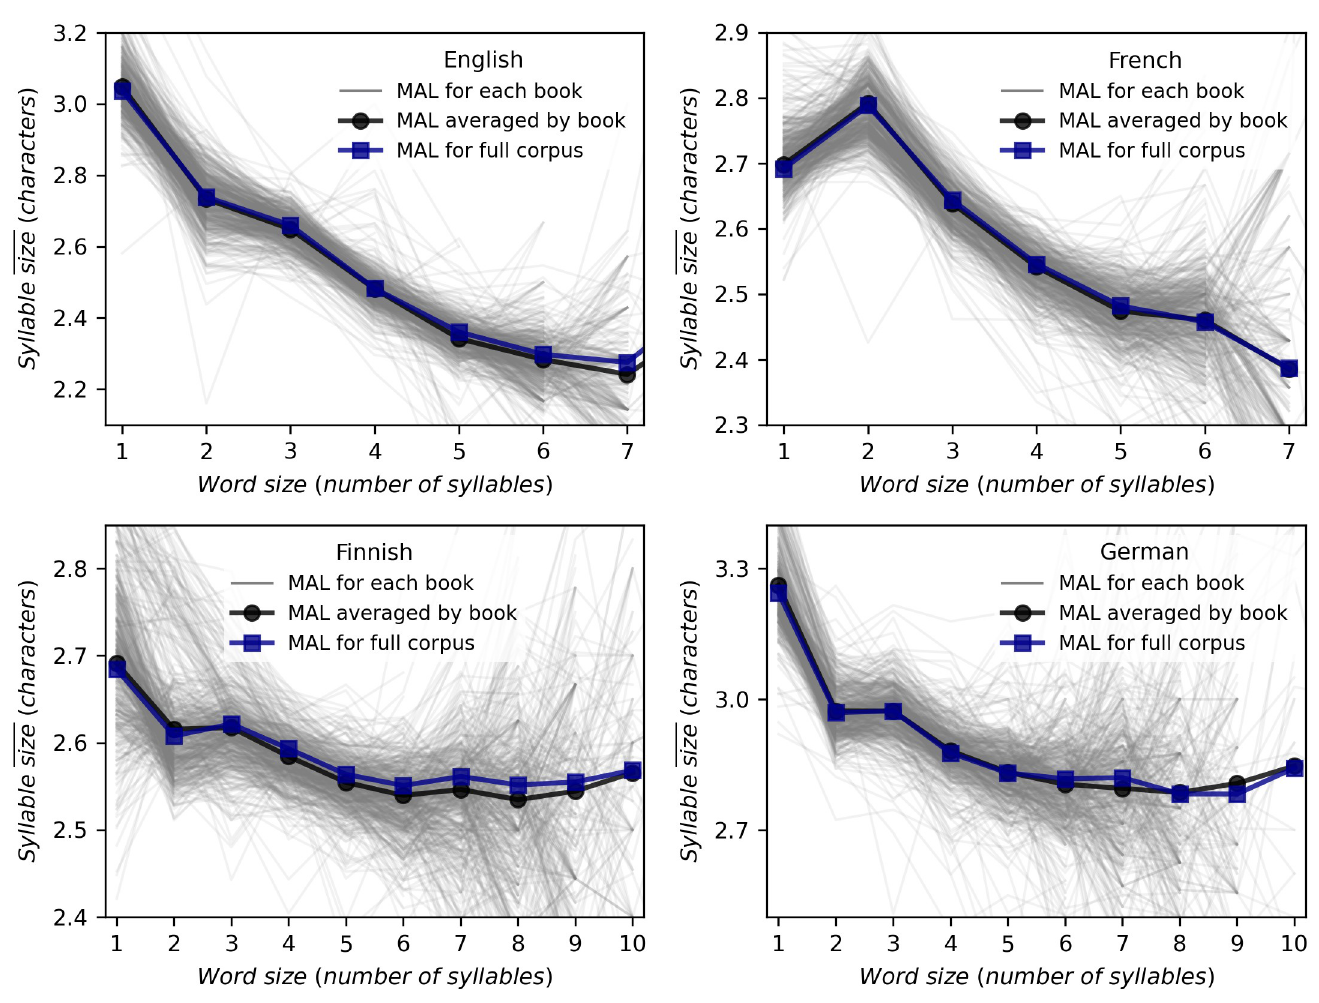
Fig 3. Different methods of computing MAL reflect similar results. Relation between word size (measured in number of syllables) versus the mean size of those syllables, where each panel corresponds to one different languages of Gutenberg corpus. Each thin grey line represents one book, whereas black circles are the mean duration of books. Meanwhile blue squares are the result of computing MAL from the full corpus. Both methods shows similar results and solid lines are just represented for visual comparison. Results on 17 additional languages are provided in S1 Fig.